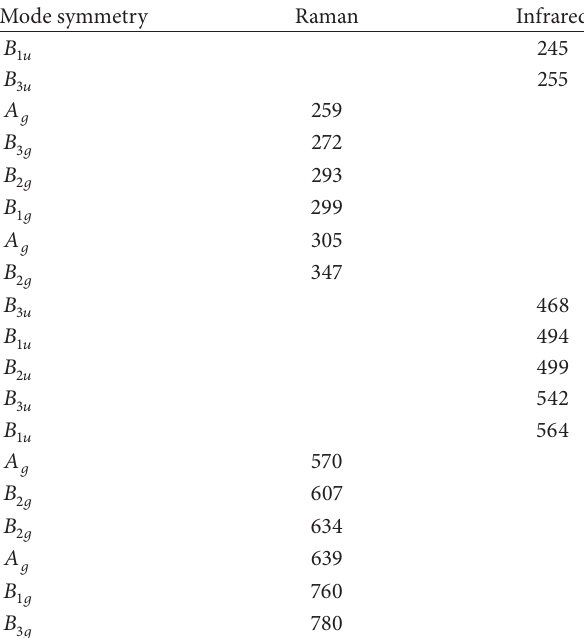
Table 4: Frequencies of the Raman and IR-active phonon modes in Ti 3 B 4 . Units: cm −1